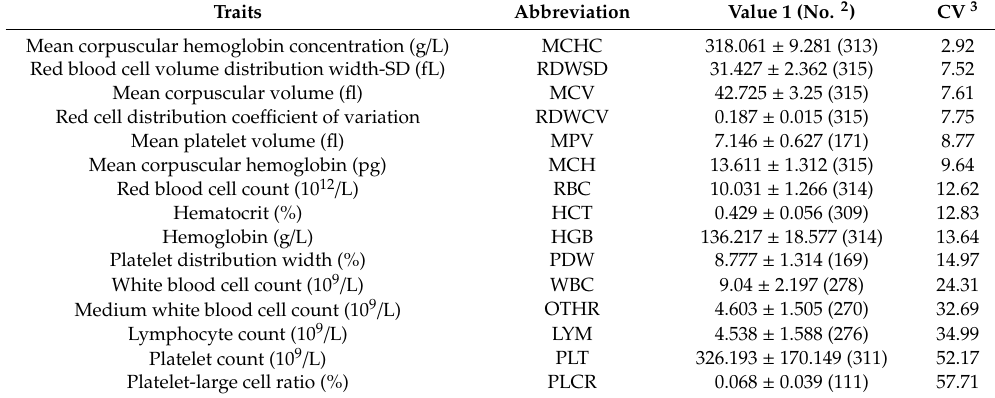
Table 1. Descriptive statistics of 15 hematological traits in the yak